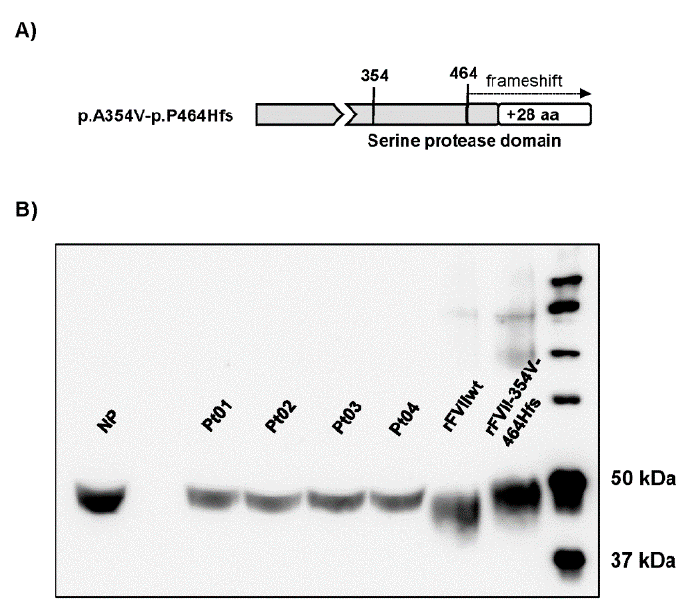
Figure 2. FVII protein forms in patients’ plasma and upon recombinant expression. ( A ) Schematic representation of the FVII p.A354V-p.P464Hfs variant. ( B ) Western blot analysis (image adjusted for brightness/contrast) of FVII in plasma from the four patients (Pt 01 – 04), a healthy volunteer (normal plasma, NP) or cell lysates from cells with stable expression of rFVIIwt or rFVII-354V-464Hfs.